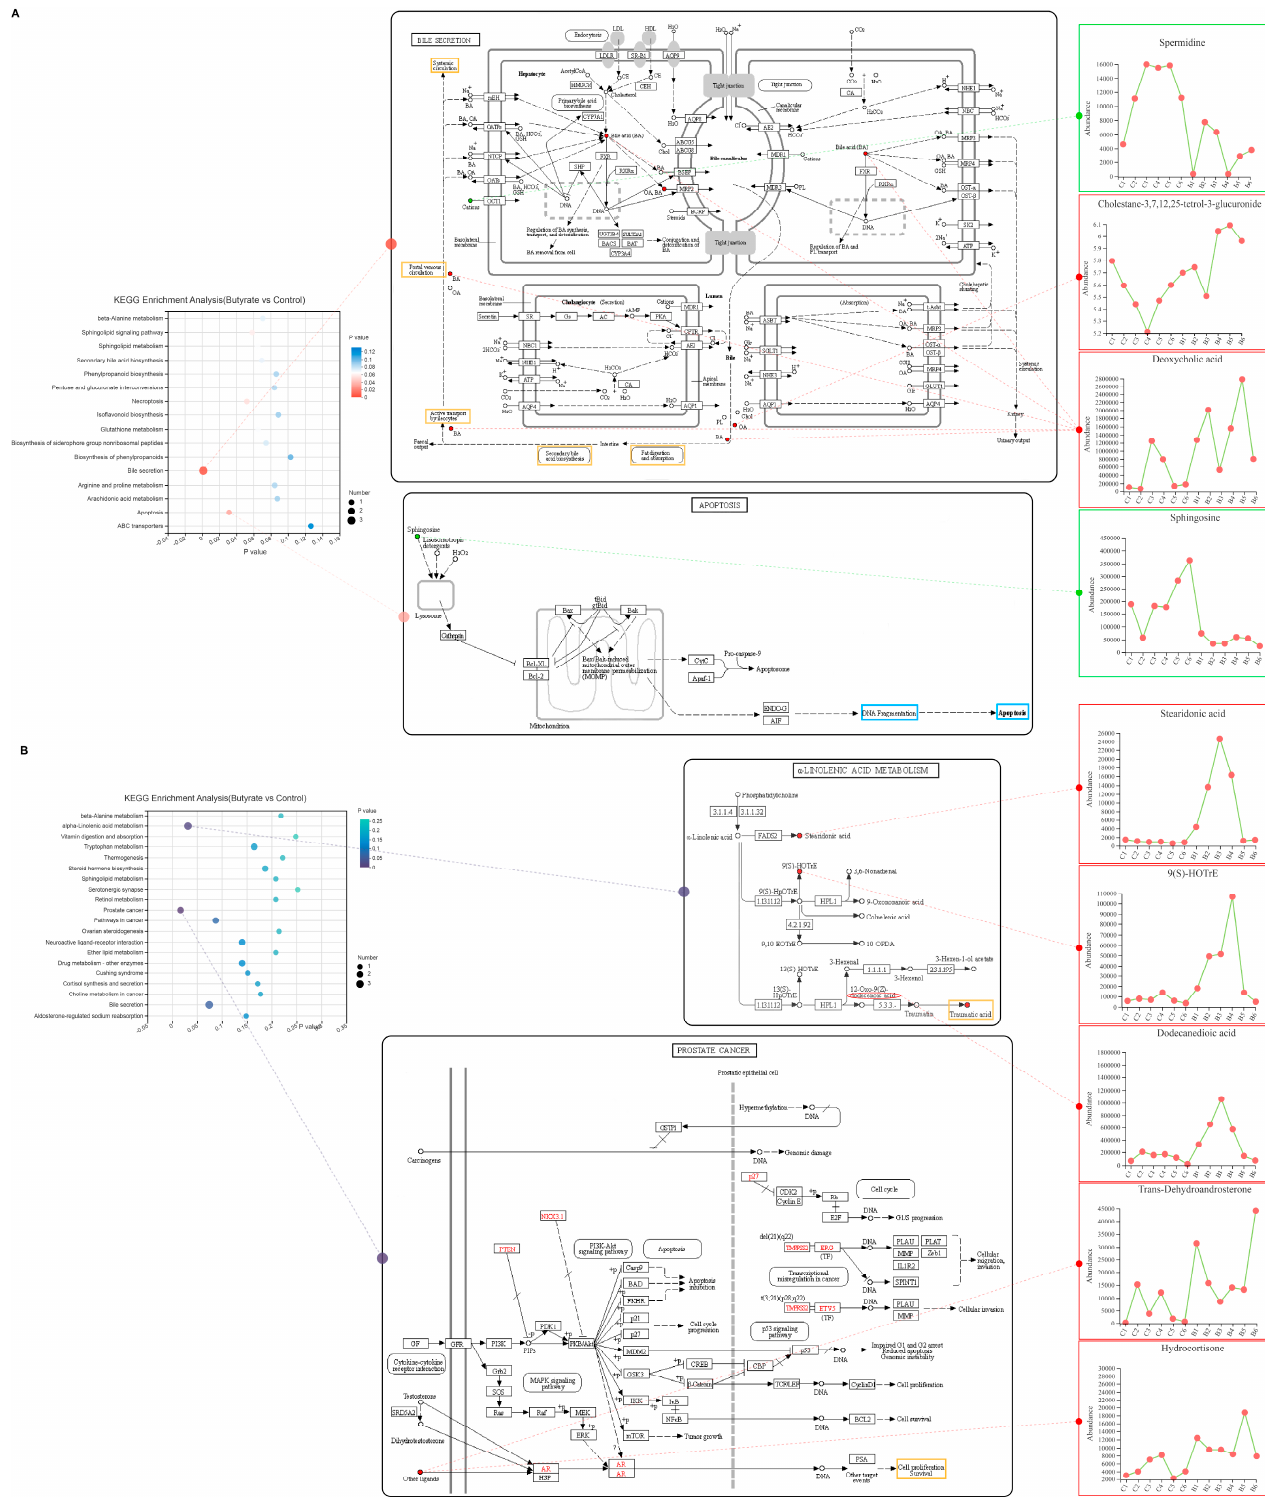
Figure 9. Metabolome KEGG pathway enrichment. ( A ) Ileal metabolome KEGG pathway enrichment. ( B ) Plasma metabolome KEGG pathway enrichment. Processes in yellow boxes are activated or upregulated; processes in blue boxes are inhibited or downregulated.